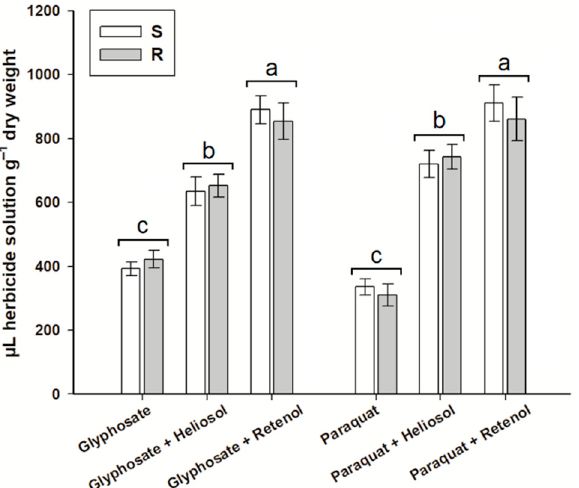
Figure 4. Foliar retention of glyphosate and paraquat in susceptible and resistant Eleusine indica plants from Colombia, using two adjuvants, Retenol ® and Trend ® 90. Histograms represent the means and vertical bars of the standard error ( n = 14). Different letters denote significant differences between treatments of the same herbicide by the 95% Tukey test.